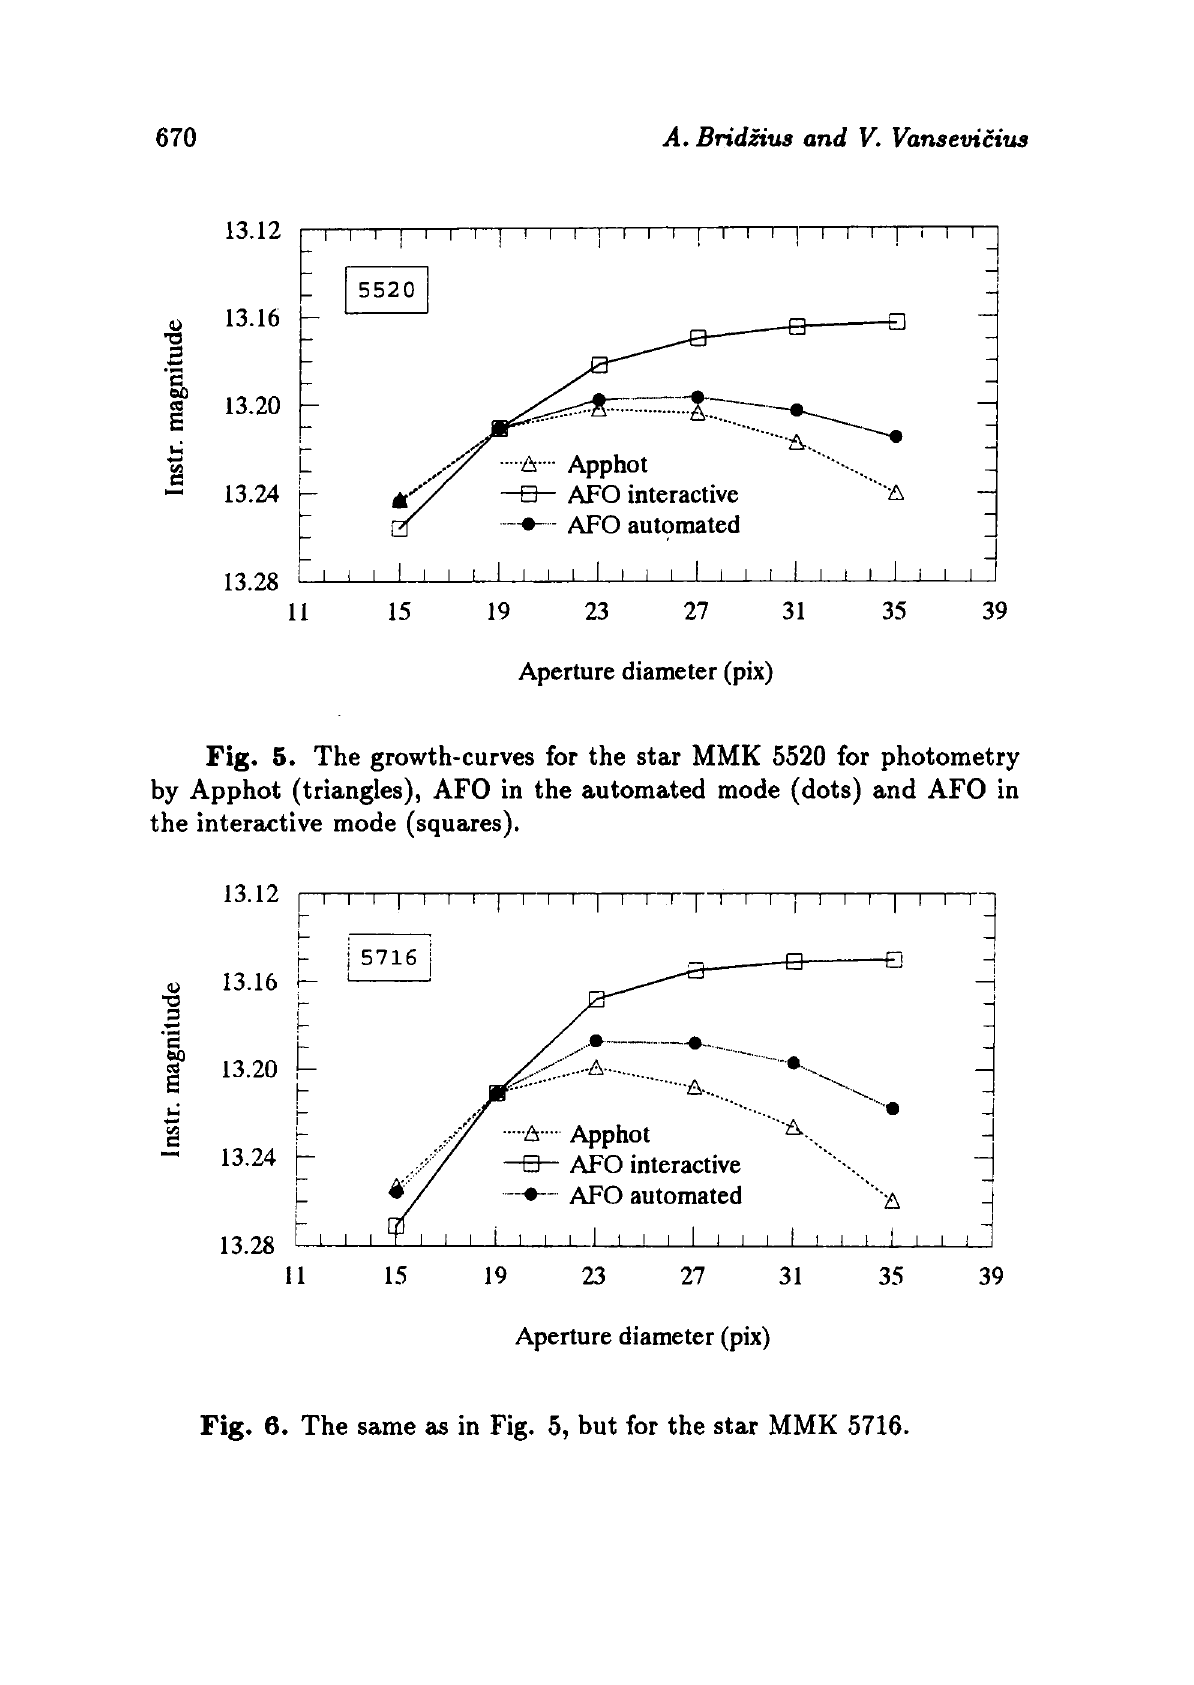
Fig. 6. The same as in Fig. 5, but for the star MMK